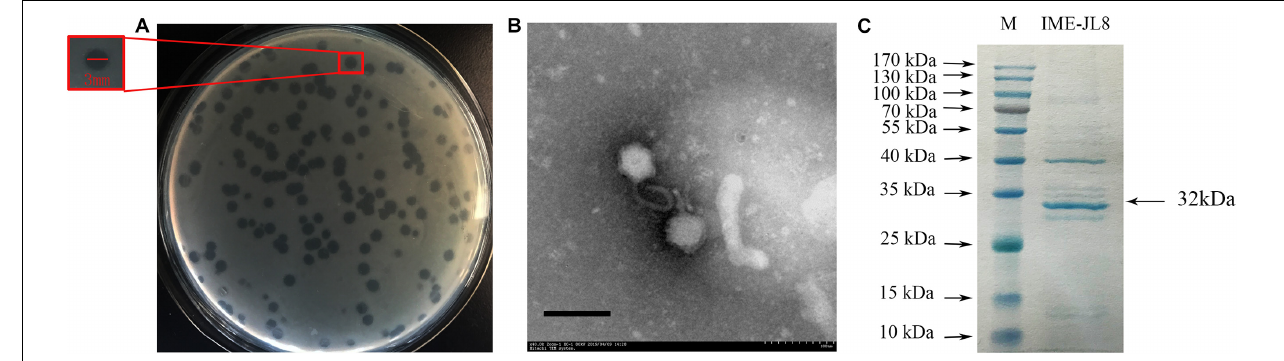
FIGURE 1 | Phage morphology and structural protein detection. (A) Bacteriophage IME-JL8 spotted onto C. freundii CF8 culture on BHI agar. Each single plaque was ≈ 3 mm diameter. (B) TEM image of IME-JL8 revealing Siphoviridae bacteriophage with long tail and icosahedral head. (C) SDS-polyacrylamide gel (15%) electrophoresis of IME-JL8 structural proteins. M: molecular mass marker. Lane 1, IME-JL8 proteins. The most abundant structural protein was about 32 kDa.